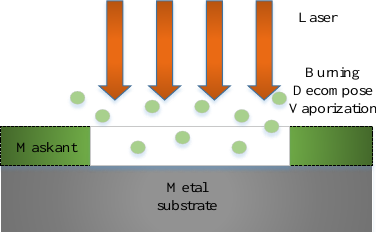
Figure 9. Mechanism of laser scribing.